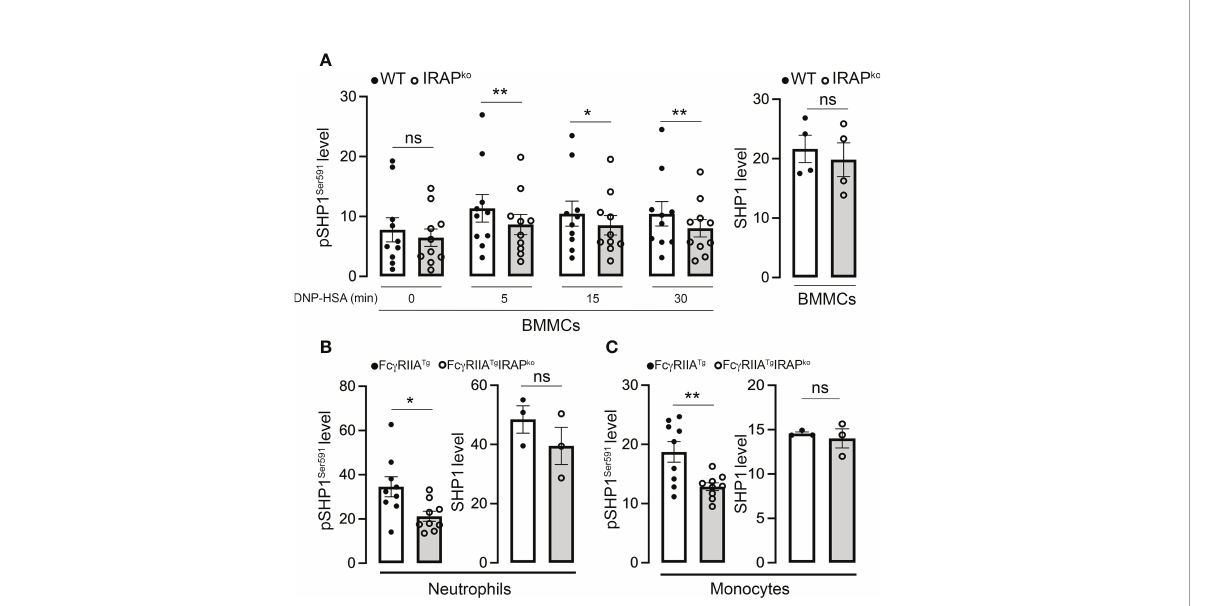
FIGURE 7 IRAP-de fi cient cells show less SHP1-inactivating phosphorylation on Ser591. (A) Anti-DNP IgE sensitized WT and IRAP-de fi cient (IRAP KO ) BMMCs were stimulated with speci fi c antigen (30 ng/mL of DNP-HSA) for indicated time points and levels of the SHP1 S591 phosphorylation response were determined at indicated time points by phos fl ow analysis using anti-SHP1 S591 (left panel). Total levels of proteins of resting cells were analyzed using anti-SHP1 (right panel). (B, C) SHP1 phosphorylation on Ser591 was also determined on IgG-stimulated neutrophils (B) and monocytes (C) during ASA analyzed ex vivo using phos fl ow analysis. Cells were accessed directly from the blood 5 min after initiation of ASA. The gating strategies for analysis of BMMCs, neutrophils and monocytes and representative examples of Ab staining are shown, respectively in (Supplementary Figures 2B, C). Phosphorylation levels in (A – C) were determined as the ratio of the gMFI of samples divided by the gMFI of the Isotype of the respective sample and represent the mean ± s.e.m of indicated experiments. Statistical analysis was done using a Student ’ s test. *: P < 0.05; **: P < 0.01; ns, not signi fi